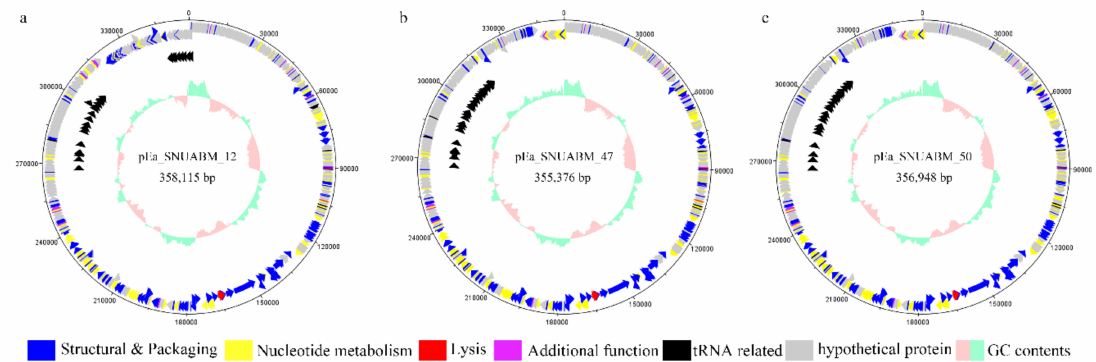
Figure 5. Whole genome map of Erwinia phages ( a ) pEa_SNUABM_12; ( b ) pEa_SNUABM_47; and ( c ) pEa_SNUABM_50. Predicted ORFs were functionally categorized and colored; Blue represents proteinswithstructuralandpackagingfunctions, yellowrepresentsproteinswithnucleotidemetabolism functions, red represents lysis functions, purple represents proteins with additional functions, black represents tRNAs or tRNA related functions, and gray represents proteins with hypothetical functions. Scale = base